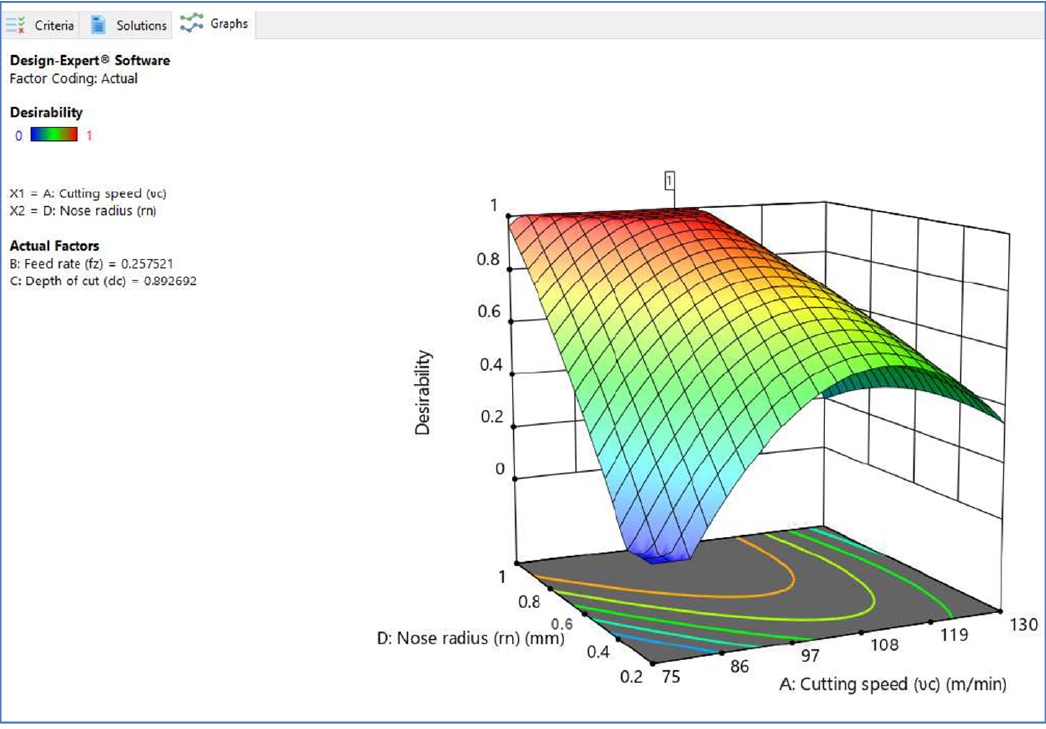
Figure 11. Surface plot on desirability (V c vs. R n ).